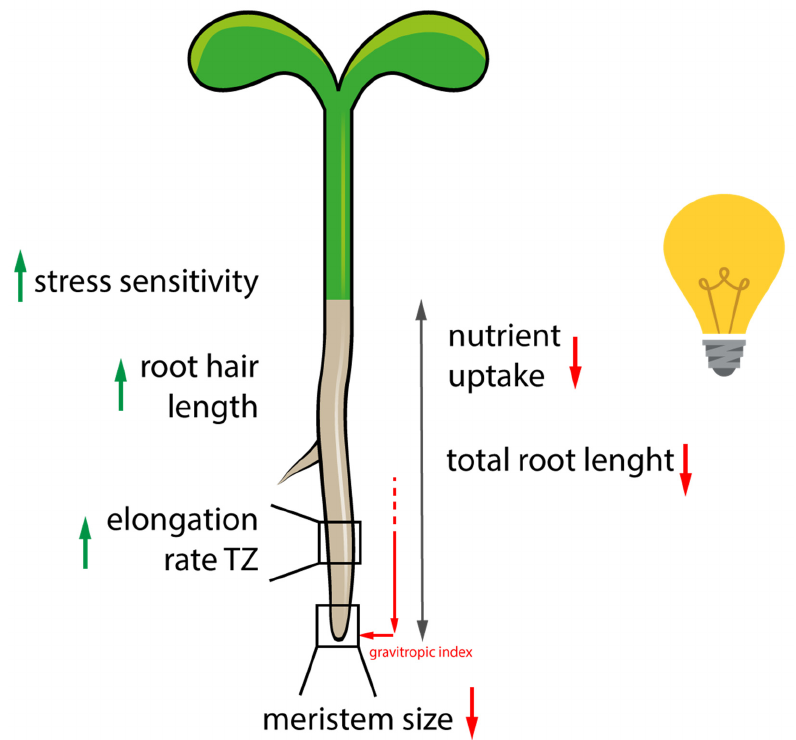
Figure 2. Summary of repeatedly observed root traits, which differ depending on the root illumination status. When roots are shaded from direct root illumination, independent studies from different laboratories confirmed a higher activity of the meristem, better efficiency in nutrient uptake, and better coordinated directional root growth. Furthermore, cell elongation rate in the transition zone (TZ) is reduced, as the light-induced Root Escape Mechanism is missing. Moreover, light-grown roots show enhanced sensibility towards additive stress treatment and cope less efficiently or slower upon stress application, probably due to elevated reactive oxygen species production (ROS), which activates stress response signaling pathways. Elevated ROS levels are suspected further to induce root hair outgrowth and elongation closer to the meristem in light-grown roots.